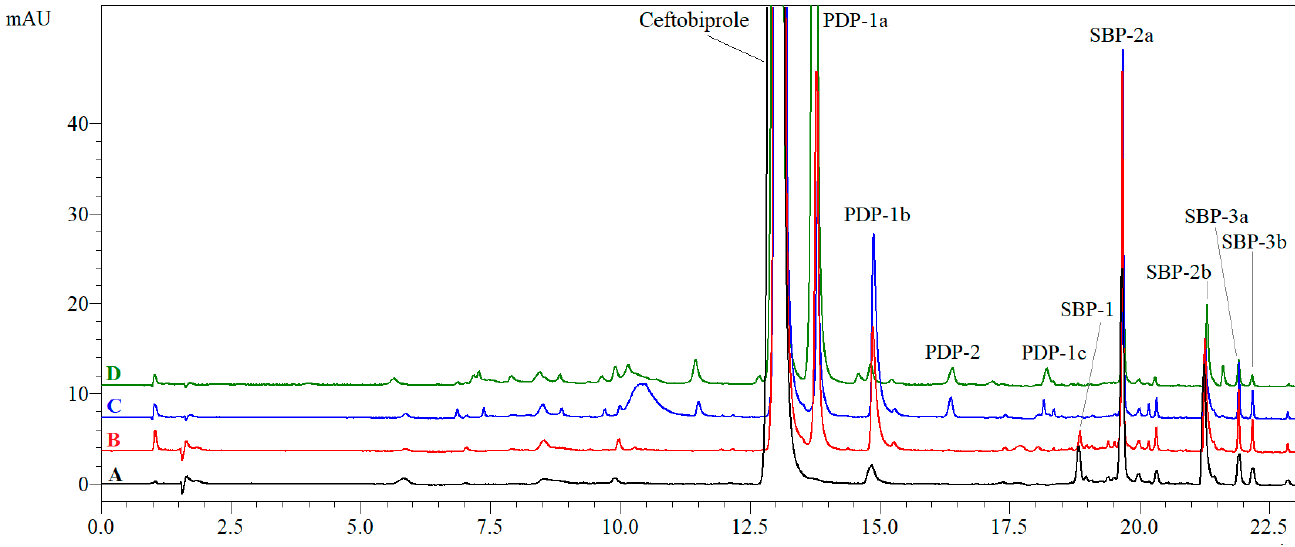
Figure 9. Overlaid chromatograms obtained from the separation of a 1 mg/mL ceftobiprole solution by photolytic degradation: ( A ) in 10% DMSO at time 0; ( B ) irradiation at λ = 254 nm in 10% DMSO after 360 min; ( C ) irradiation at λ = 254 nm in 0.1 M HCl after 360 min; ( D ) irradiation at λ = 366 nm in 0.1 M HCl after 360 min.